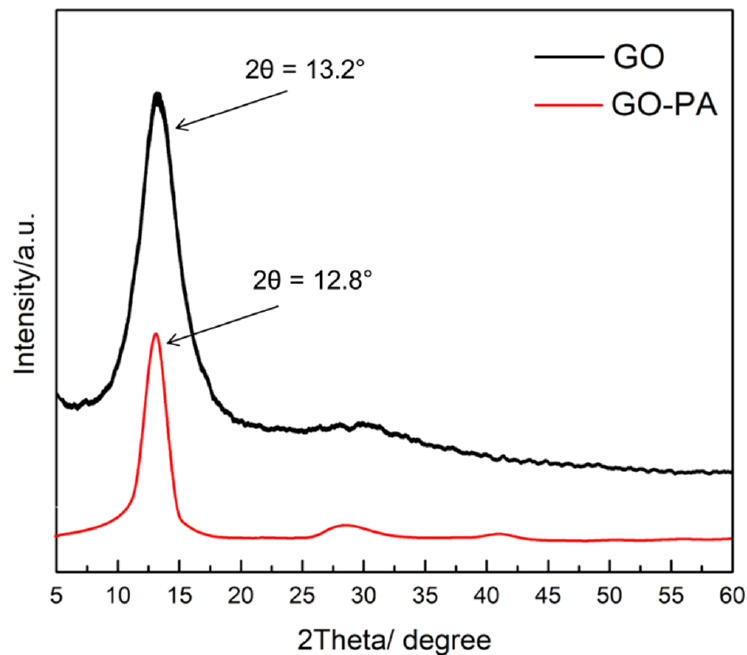
Figure 8. XRD patterns for GO and PA-GO